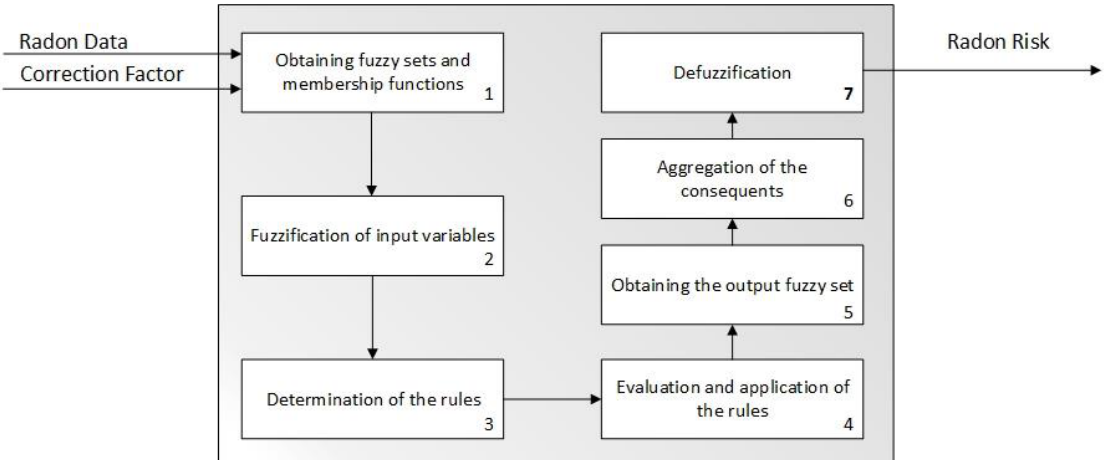
Figure 4. Inference System for the Radon Risk.